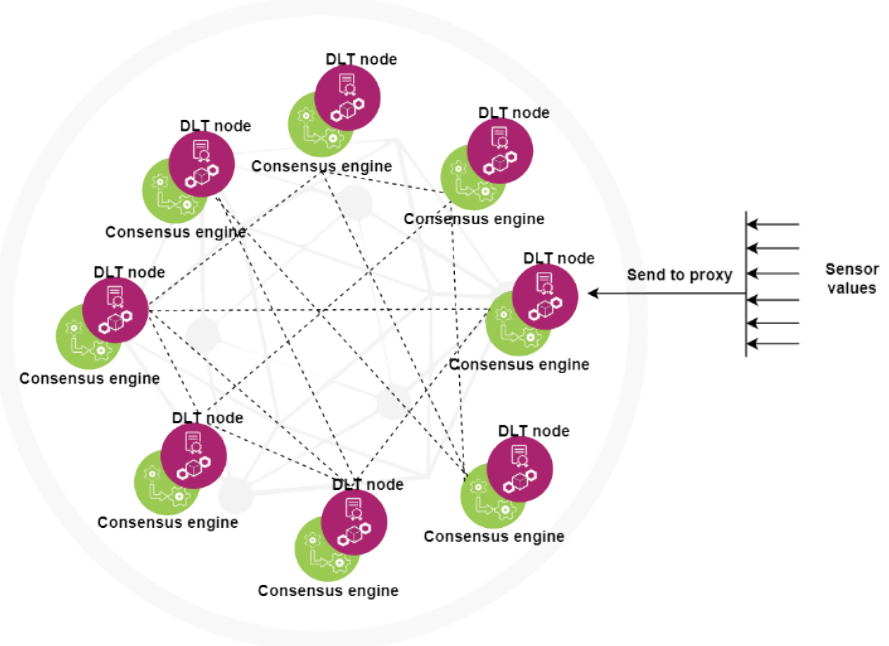
Figure 1. Nodes with the associated consensus engine.